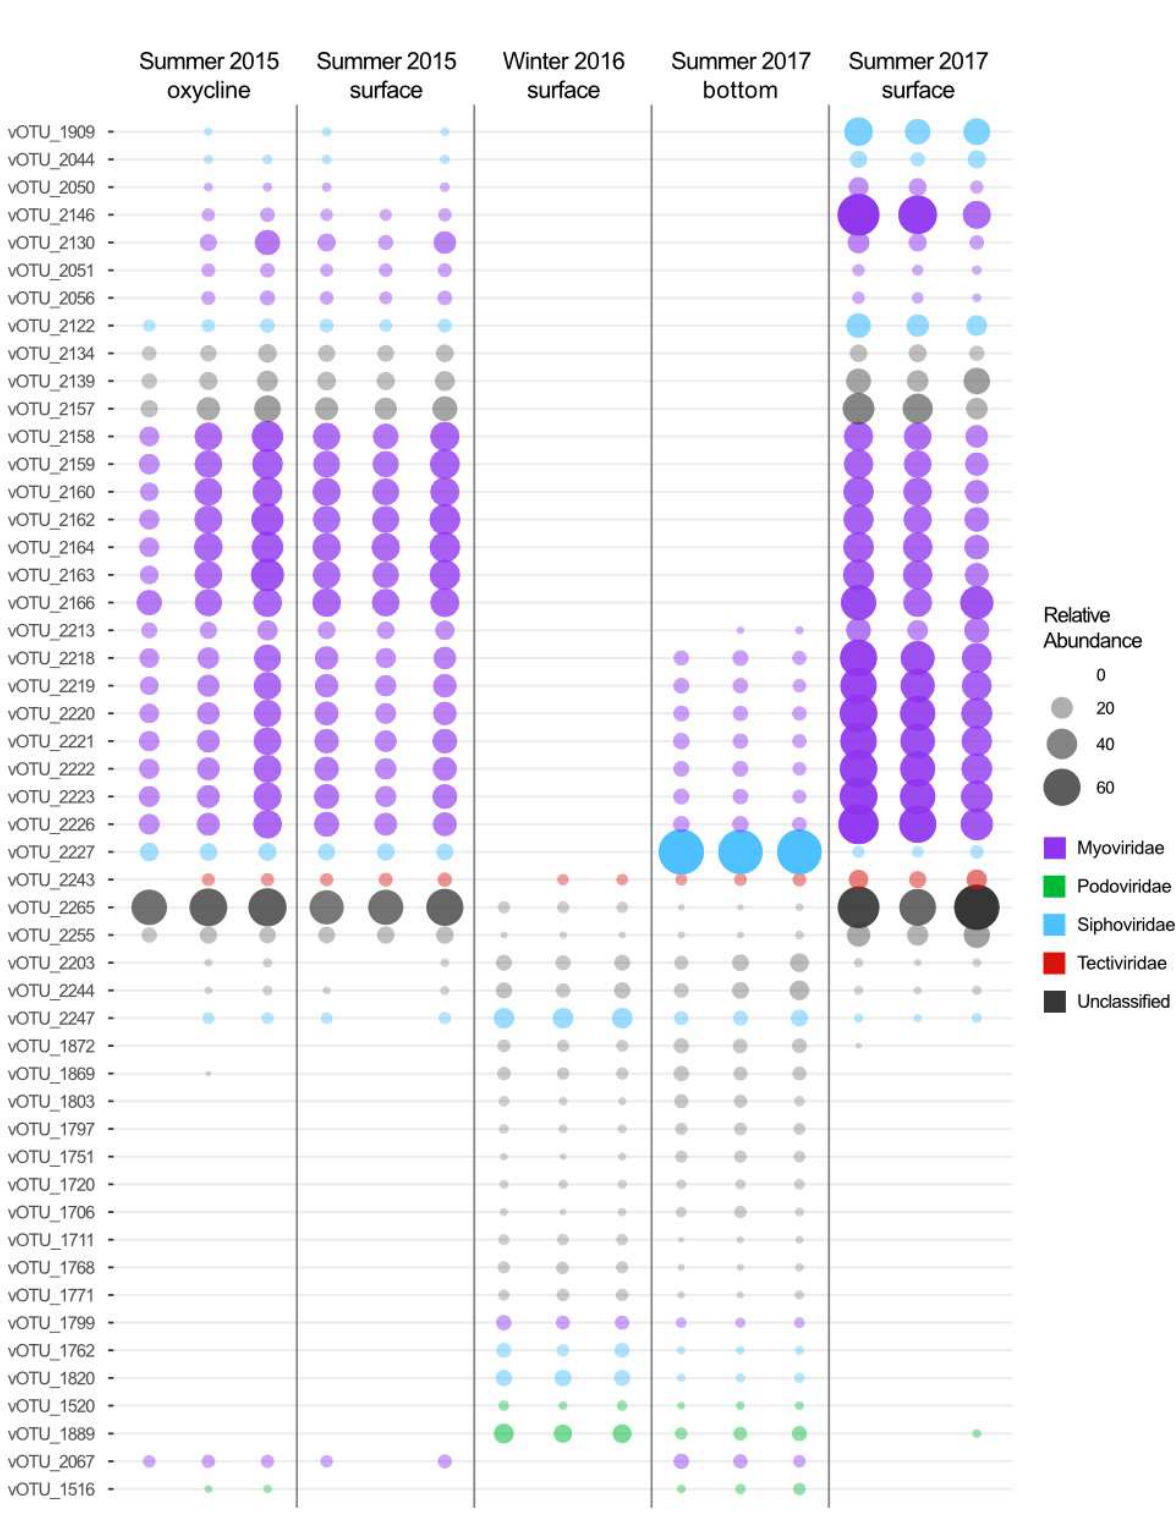
Figure 3. Relative abundance and assigned taxonomy of the 50 vOTUs most representative of the difference between sampling conditions. The 50 vOTUs were selected through random forest analysis with four sampling condition categories (summer surface, summer oxycline, summer bottom and winter). Taxonomy was assigned with VPF-Class.